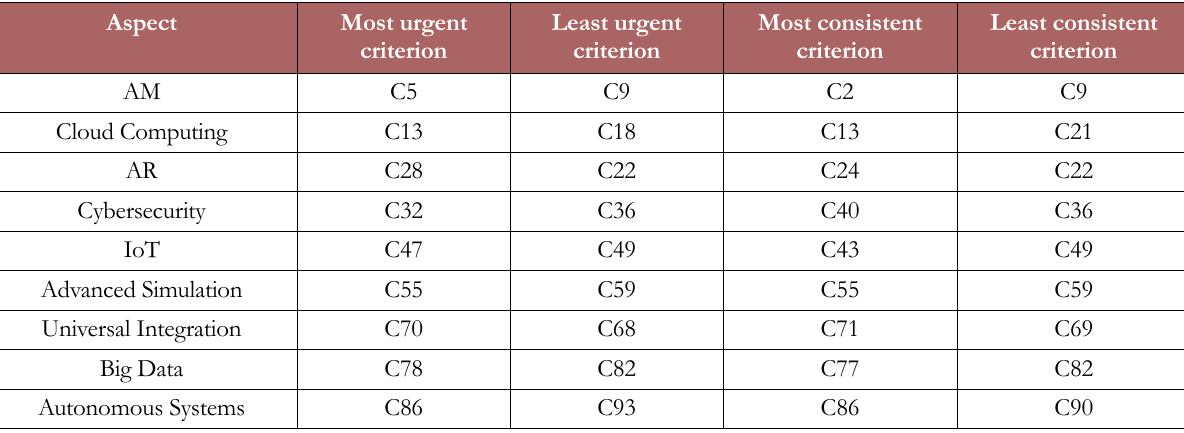
Table 22. Descriptive statistics of criteria at the organization level based on